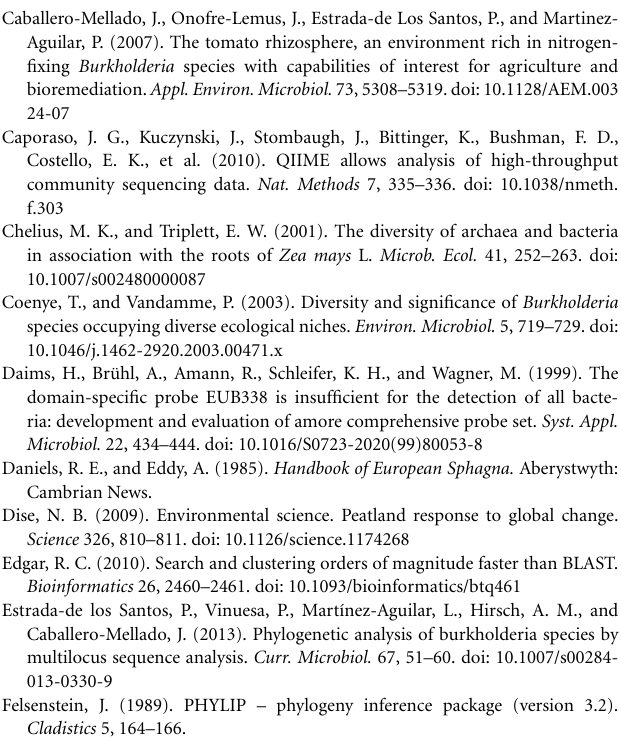
Table S1 | Sampling sites. Table S2 | Weighted UniFrac distance matrix of 16S rDNA pyrosequencing libraries specific for Burkholderia . Figure S1 | Rarefaction curves for 16S rDNA amplicon libraries of Sphagnum